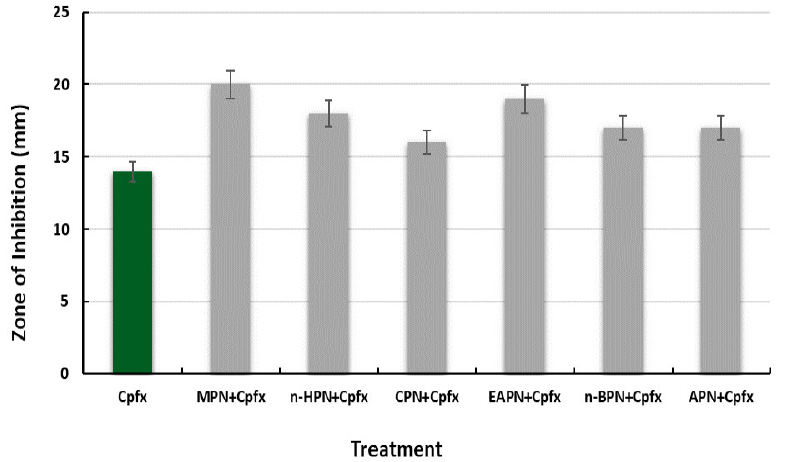
Figure 11. Antibiotic reversal activity of P. nigrum extracts in combination with ciprofloxacin (5 μg) for S. typhi .